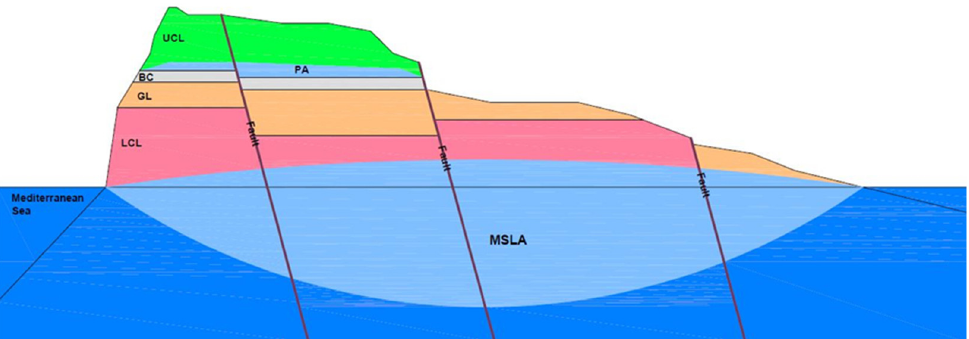
Figure 3. Conceptual cross section of the Mean Sea Level Aquifer (MSLA) and the Perched Aquifer (PA) of Malta (modified after [1]). The vertical scale is highly exaggerated, with the scale above sea level greater than the scale below sea level.